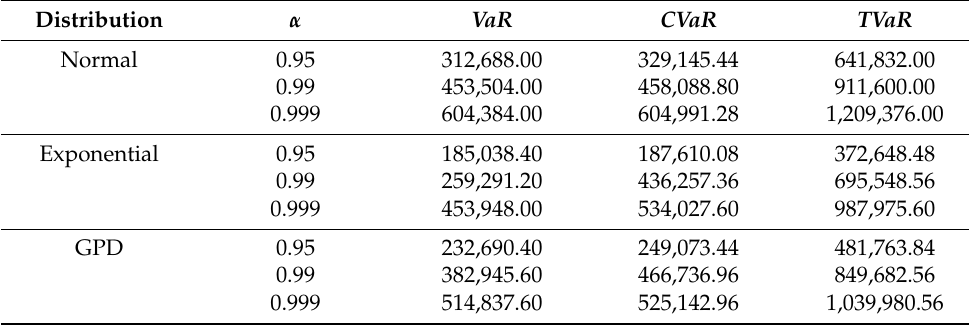
Table 4. Value of risk of loss on capital